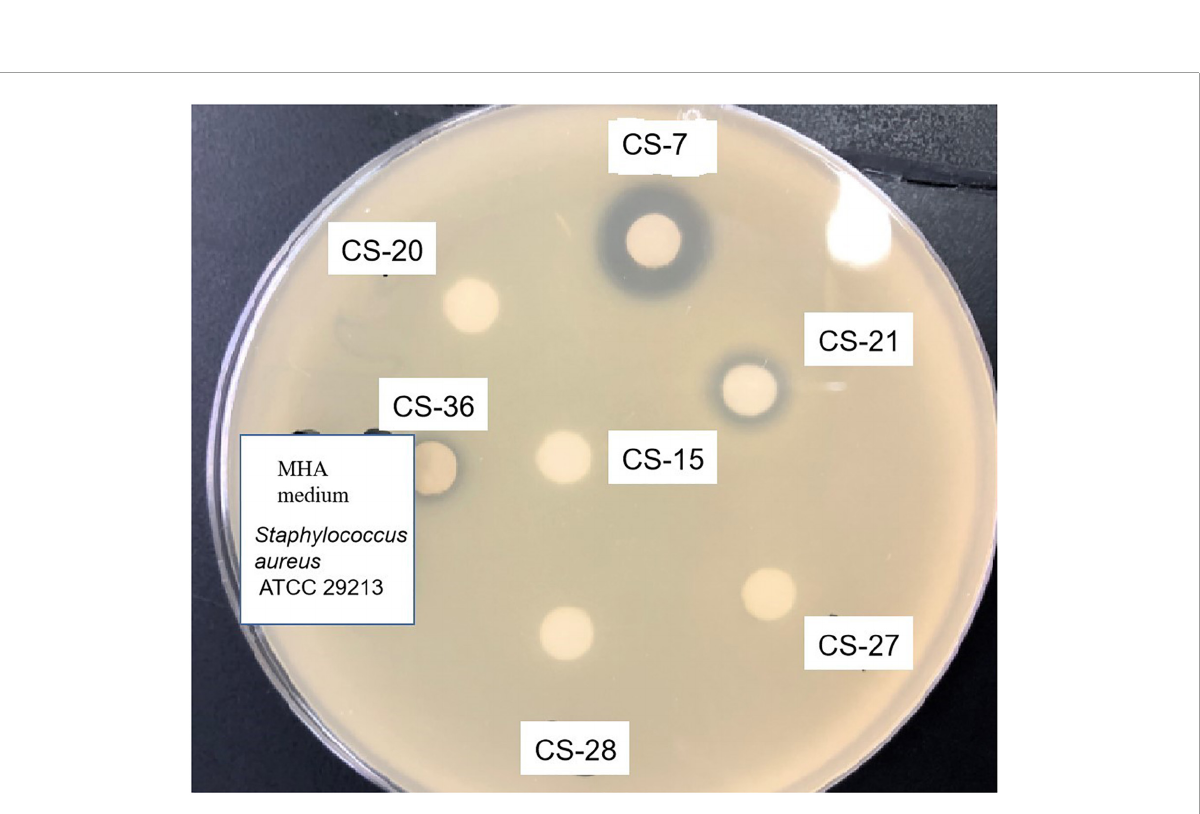
FIGURE2 Antimicrobial activity test of Streptomyces isolated from soil samples. Methanolic extracts of Streptomyces bacteria were analyzed by disk diffusion methods. The appearance of inhibition zones indicated the antimicrobial activity against the indicator Staphylococcus aureus .